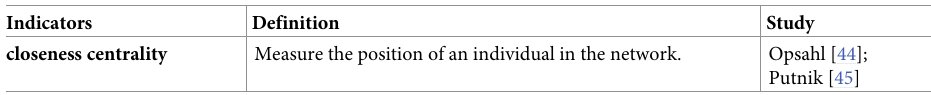
Table 4. Introduction of indicators for Question